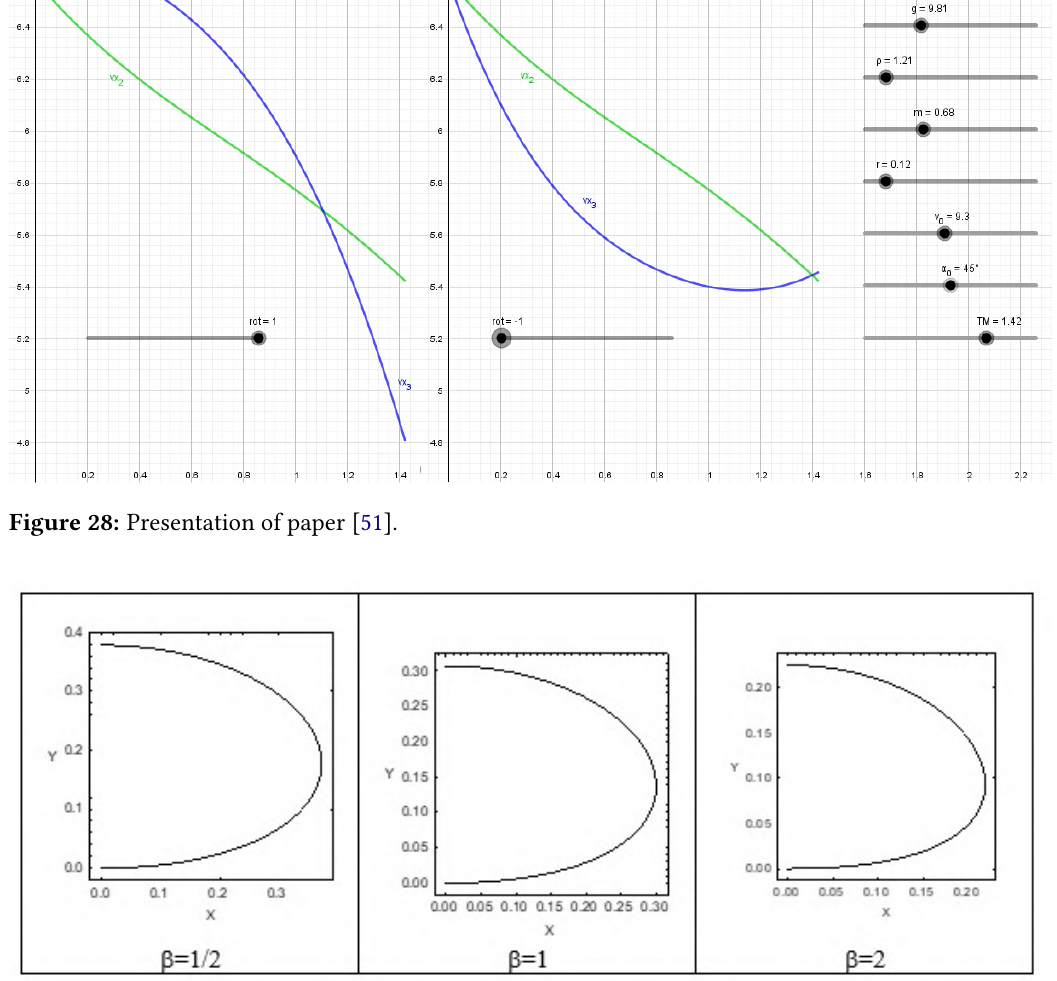
Figure 29: Presentation of paper